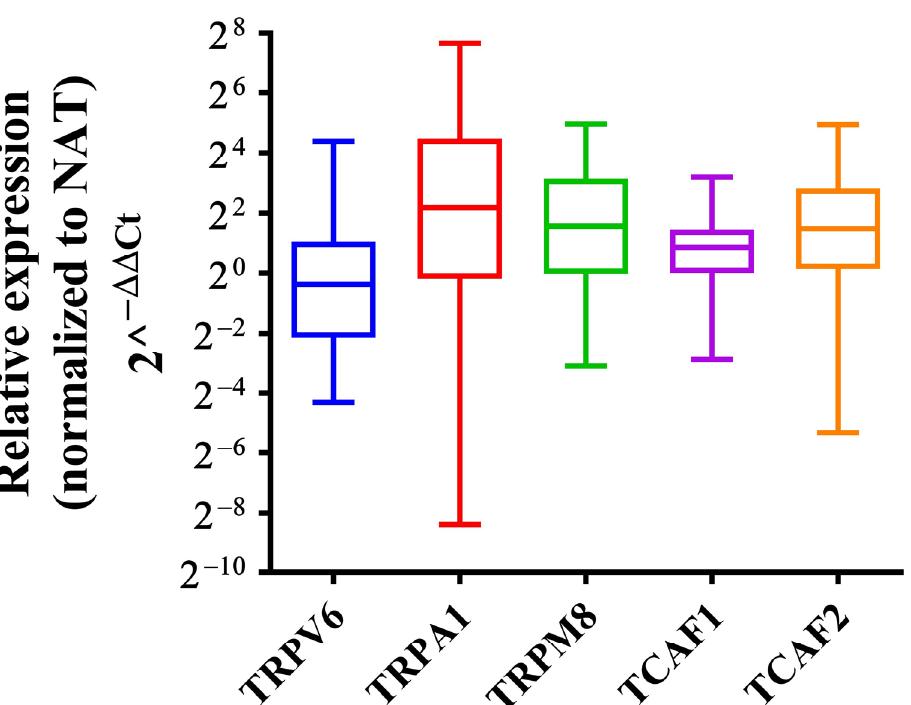
Figure 5. Boxplots of relative expression levels of the selected TRP genes in tissues of PDAC patients included in the validation cohort. Relative expression was calculated using the comparative Ct method (2 − ∆∆ Ct ) and Hu18S was used as the endogenous gene. Boxplots illustrate the median, lower, and upper quartiles of TRP expression in tumoral tissues normalized to NAT tissues.